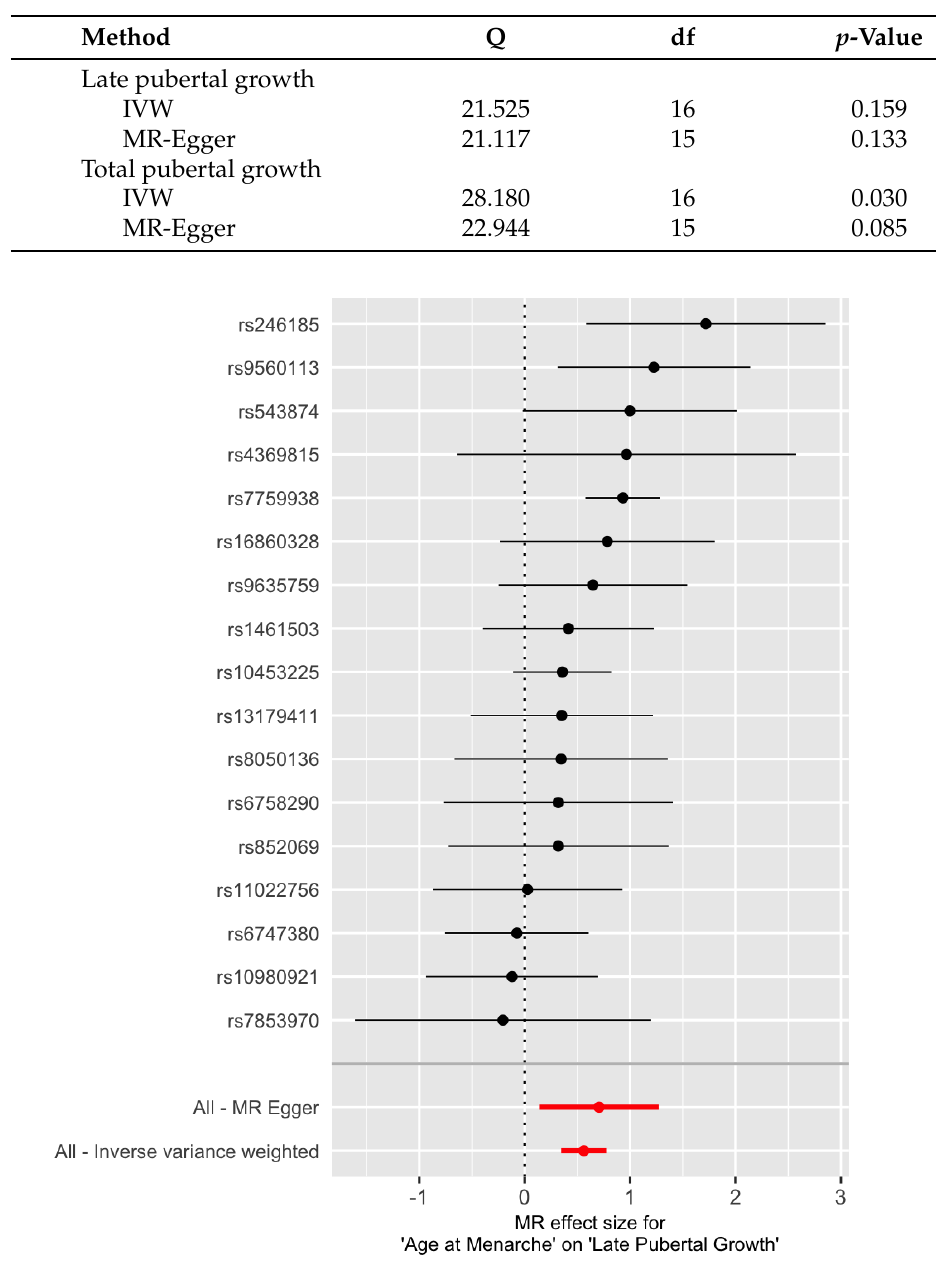
Figure 2. Forest plot of the Wald ratio Γ i / γ i at the 17 IV SNPs for later pubertal growth. The red points represent the MR